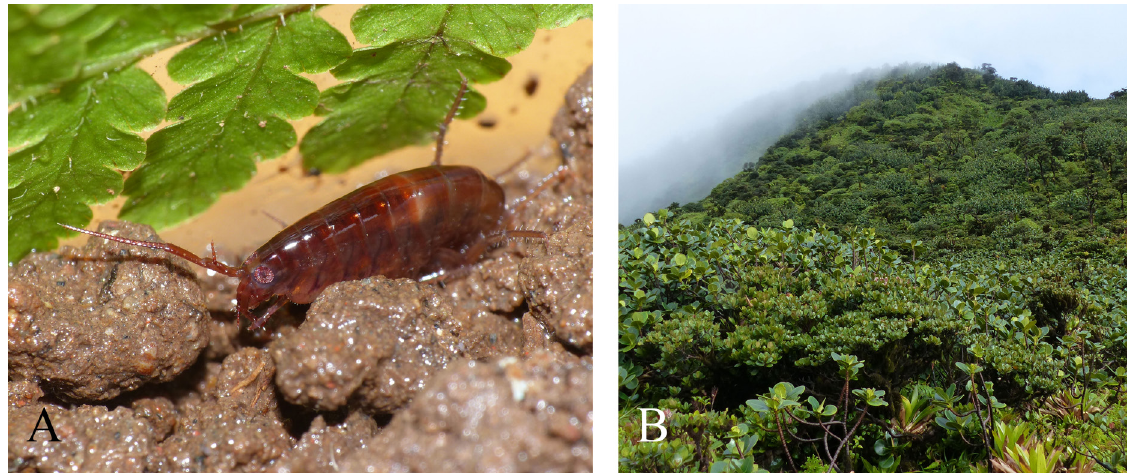
Fig. 6. Cerrorchestia taboukeli sp. nov. A . Live. B . Natural